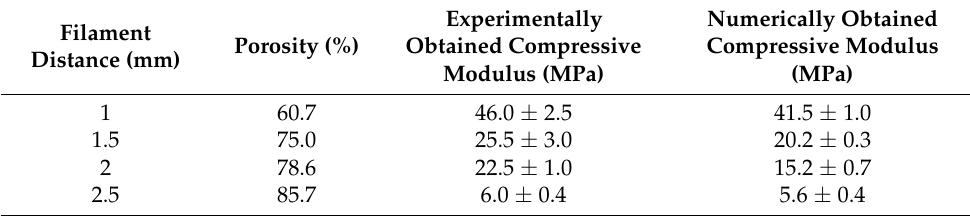
Table 2. Comparison between numerically and experimentally obtained compressive modulus.